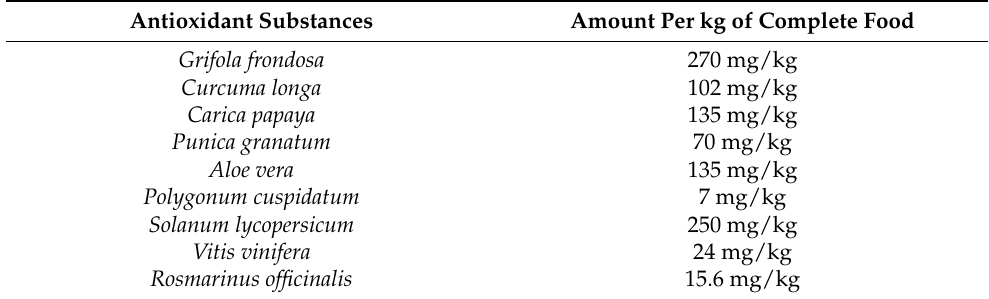
Table 1. Average substances administered to dogs depending on body weight (considering medium body